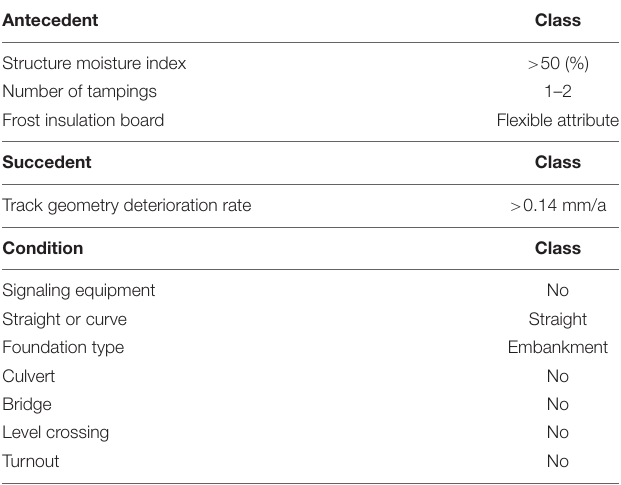
TABLE 8 | Attributes for analytical question 3